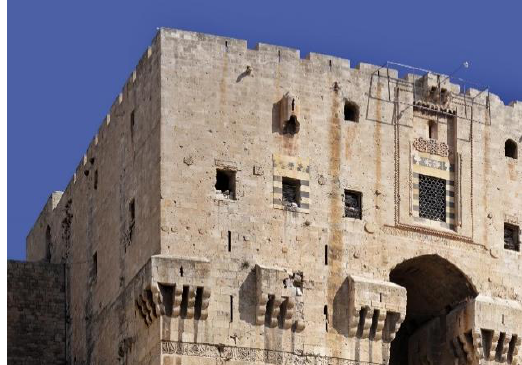
Figure 6. The entrance tower of the Citadel. The signs of the conflit are evident